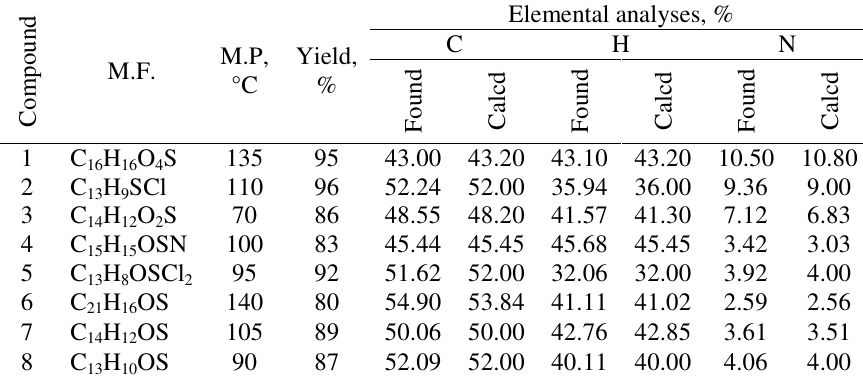
Table 1. Physical data of compounds ( 1-8